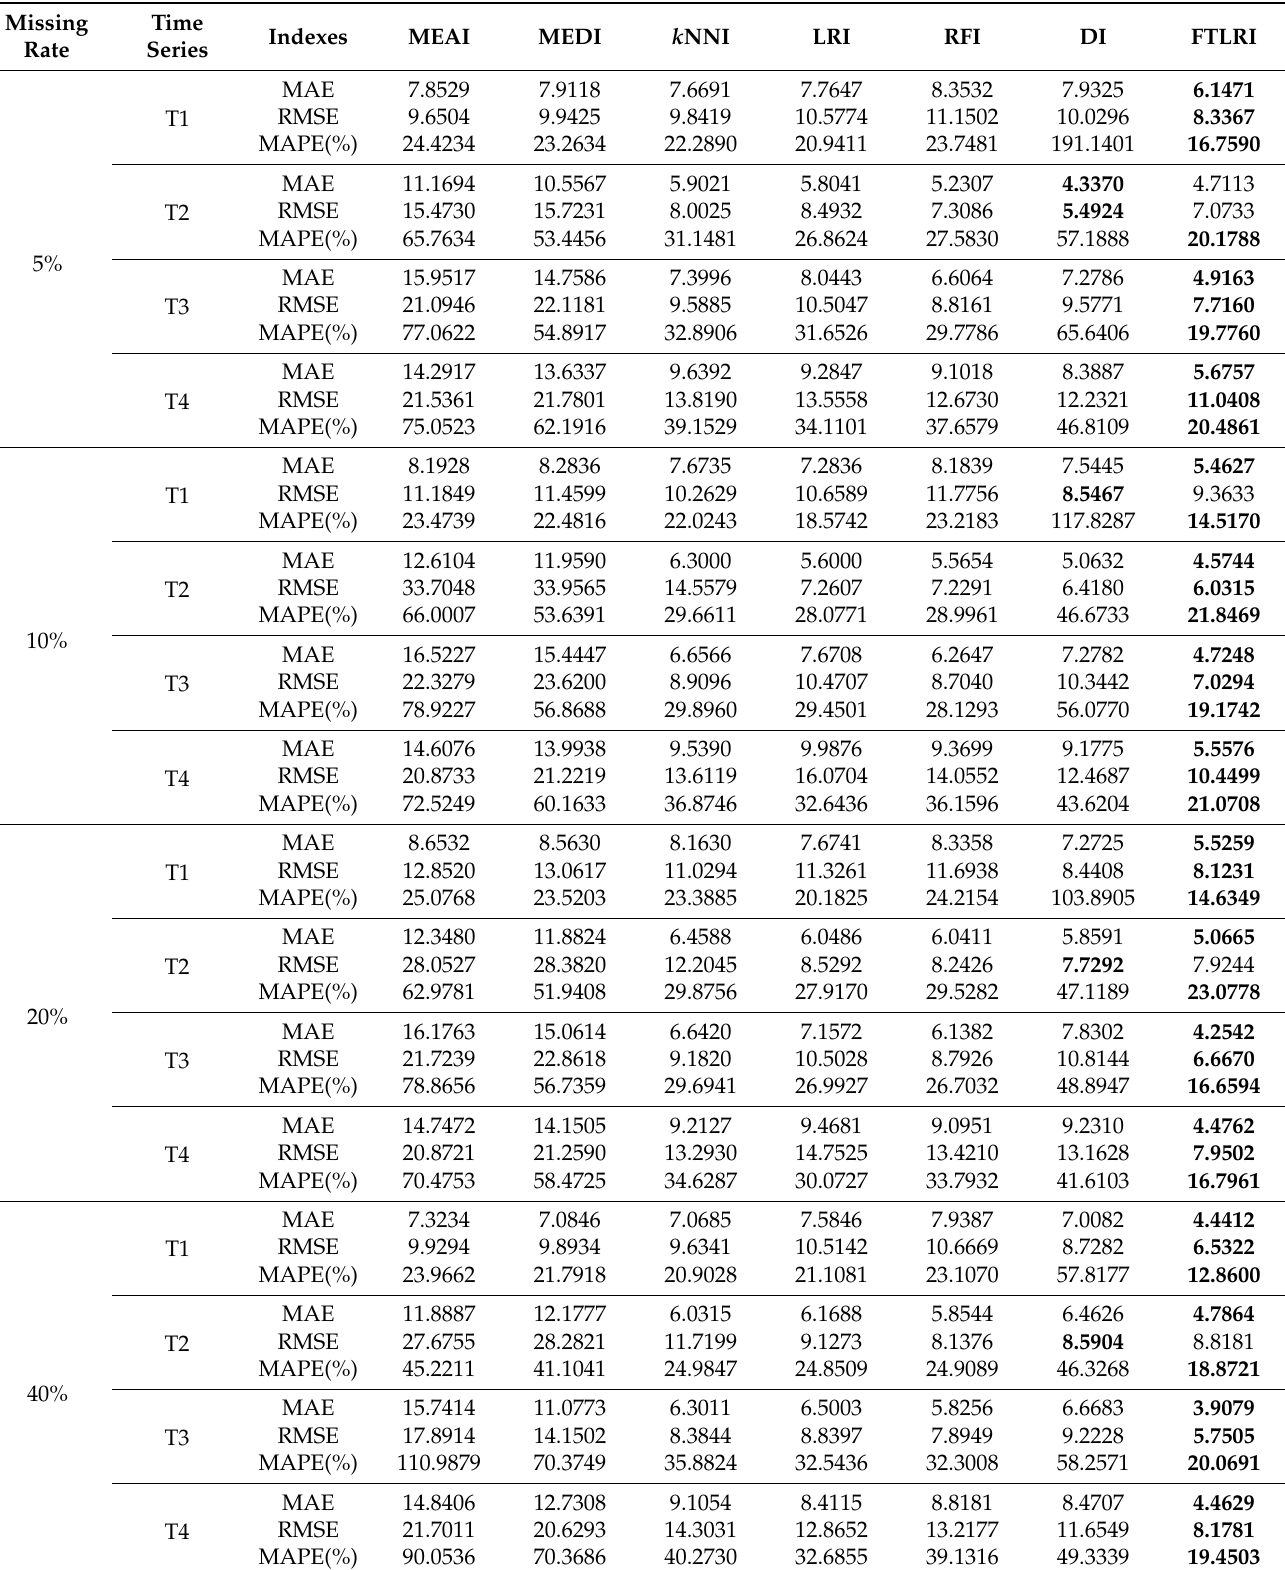
Table 7. Quantitative evaluation of imputation results of PM 2.5 at BPI under different missing rates in the short-/long-term time